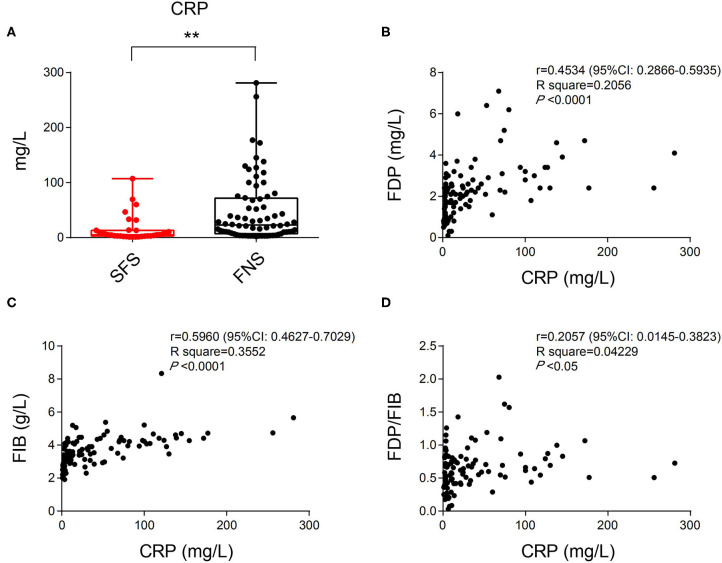
(A) The difference in CRP index between the SFS and FNS groups. (B) Correlation analysis of CRP and FDP levels showing their positive correlation. (C) Correlation analysis of CRP and FIB levels showing their positive correlation. (D) Correlation analysis of CRP and FDP/FIB ratios showing their positive correlation. **P < 0.01.